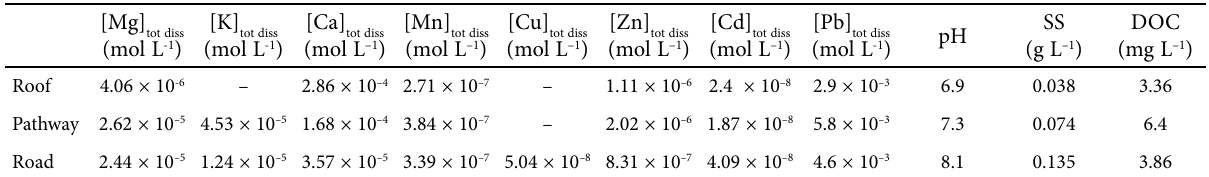
Table 2. WHAM modelling input data for pH, dissolved organic carbon (DOC), suspended solids (SS), and metal concentration as measured in the urban storm water runoff analysis. [] tot diss.: total dissolved concentration of trace metals and macro elements [Mg] tot diss (mol L -1